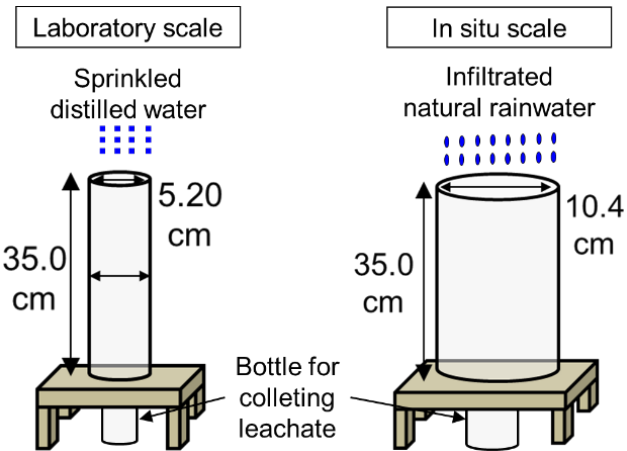
Figure 1. Schematic diagrams of laboratory and in situ column experiments. Meanwhile, RS was used as the material of the adsorption layer for the T1 sample, and mixed with the T2 sample to immobilize As. The differences in the layers of columns are due to the different As leaching concentrations; that is, the As leaching concentration from T2 sample (>0.3 mg/dm 3 ) was higher than that from T1 sample. The thickness of